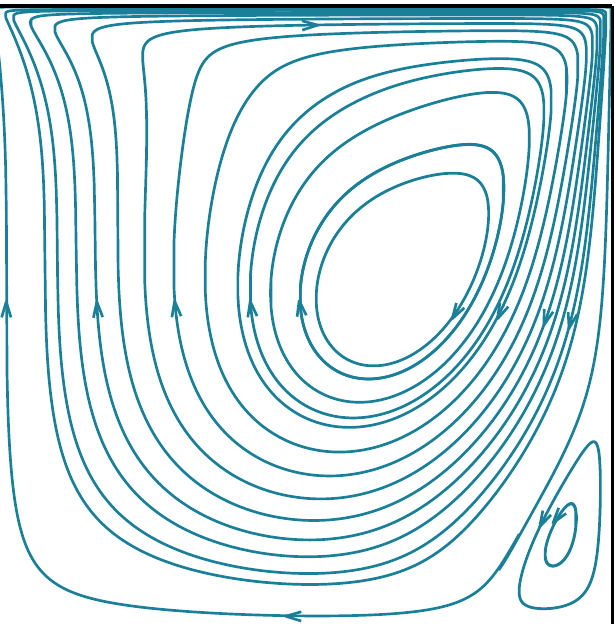
Figure 4. Streamlines corresponding to the steady-state solution of the 2D lid-driven cavity